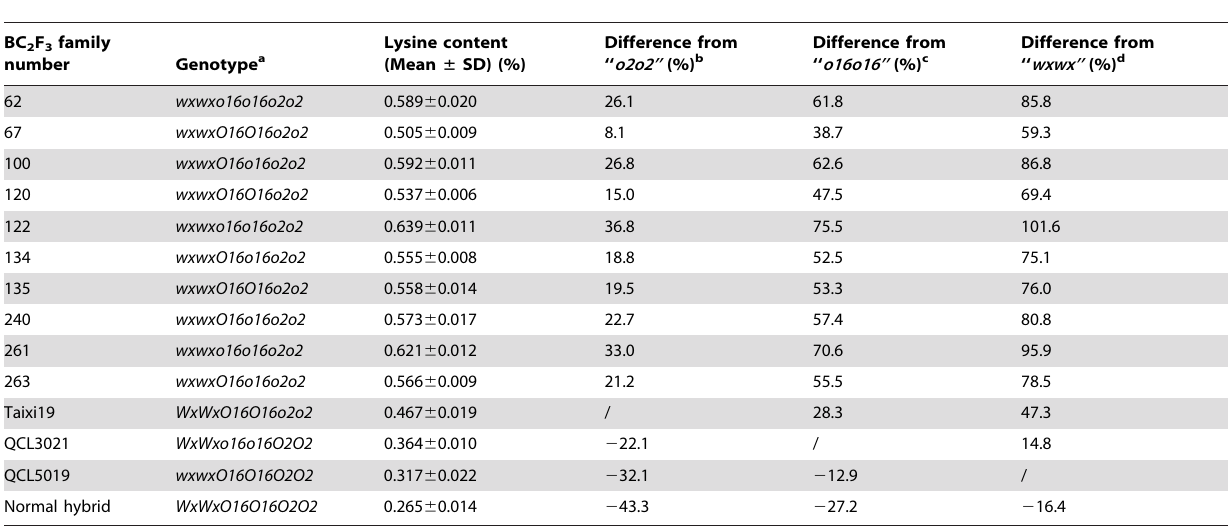
Table 7. Lysine content of 10 selected families BC 2 F 3 seeds and their parental seeds.